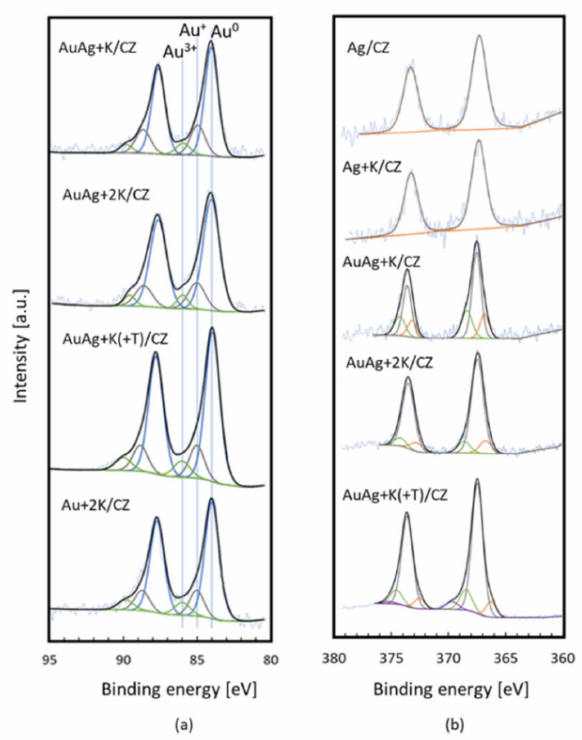
Figure 5. Detailed regions of XPS spectra: ( a ) Au 4f and ( b ) Ag3d. For silver, the shape of the peak and the Auger parameter are said to be a better indication of the oxidation state than the binding energy of the Ag 3d 5/2 peak itself [27,28]. Therefore, the Auger parameter was calculated for each catalyst and collected in Table 2. It is noticeable that there is a difference between the values obtained for the monometallic silver catalysts and those obtained for the bimetallic systems, which are accompanied by a difference in the shape. The higher Auger parameter and a symmetrical peak are typical for metallic silver [27], whereas the lower value and an asymmetric peak are associated with the presence of AgO, a salt containing both Ag + and Ag 3+ ions [27,29]. The peaks were fitted accordingly. The overall amount of silver on the surface of each catalyst (Table 2) indicates that there is substantial difference in the distribution of silver, but also, to a smaller extent, of potassium ions in the case of the thermally treated